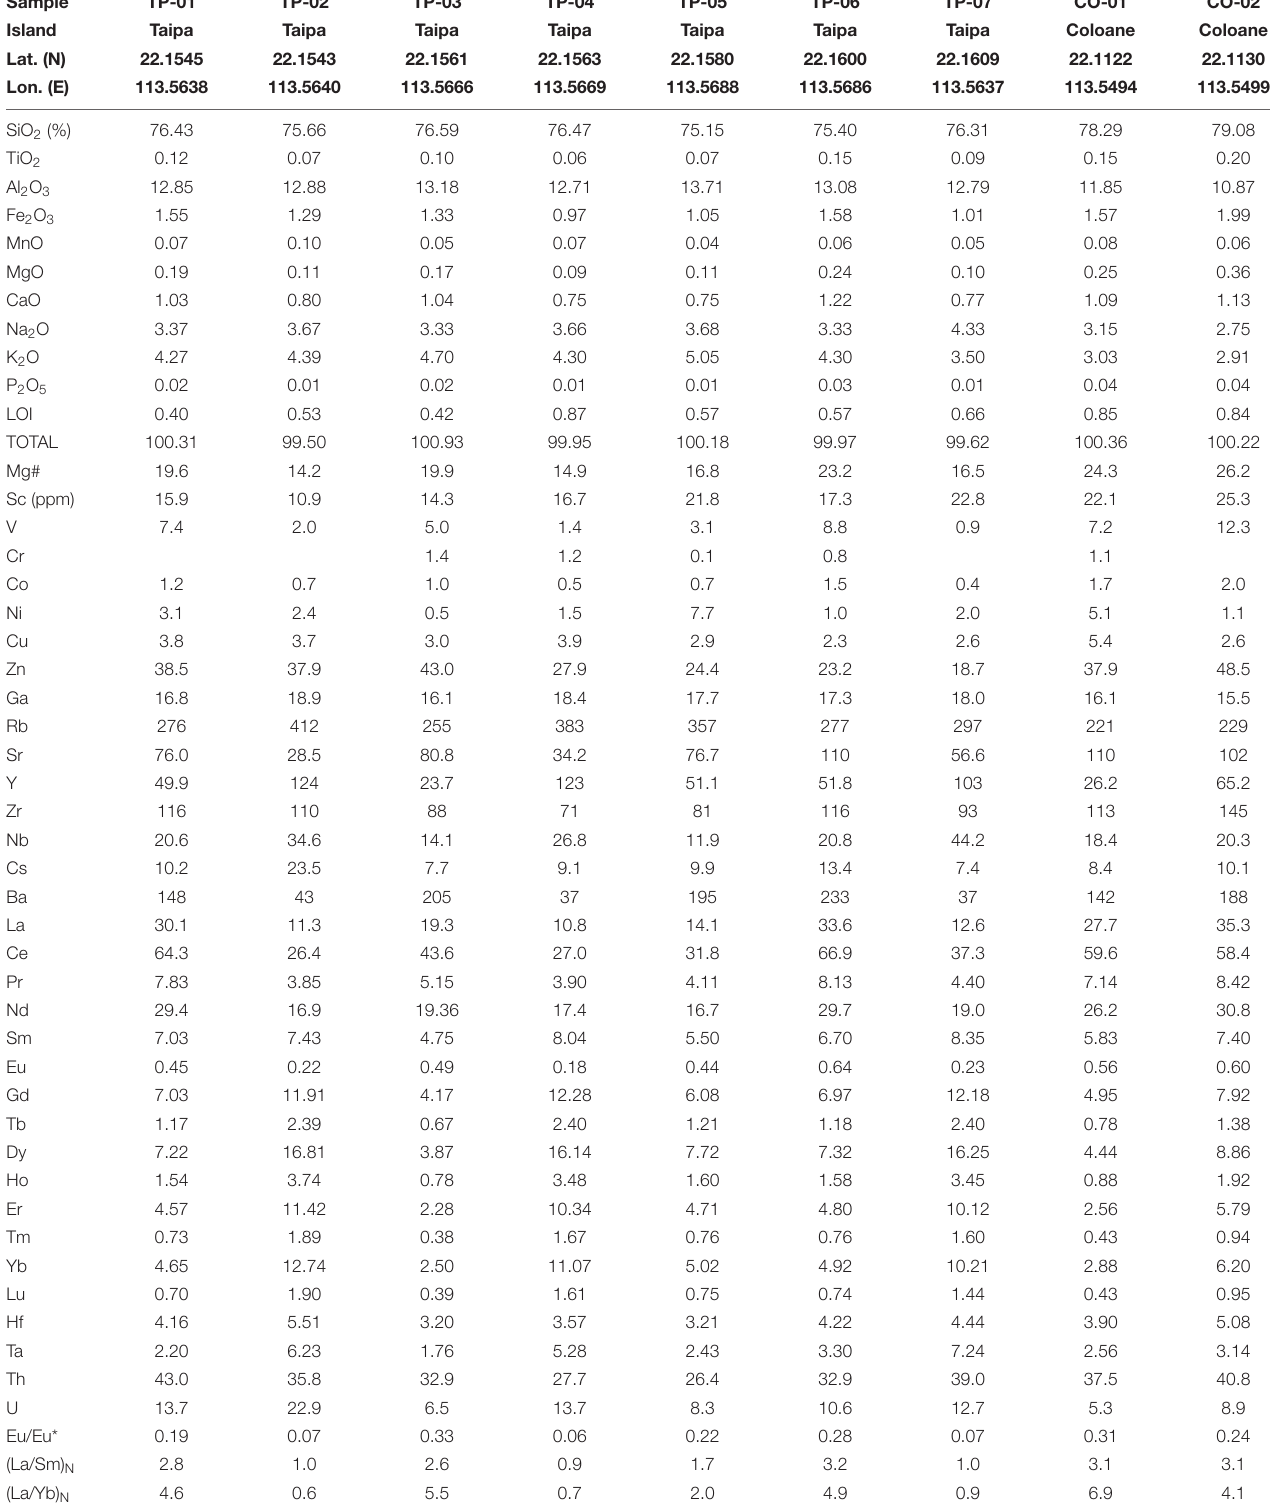
TABLE 1 | Whole-rock chemical composition of the leucogranites from Taipa and Coloane.